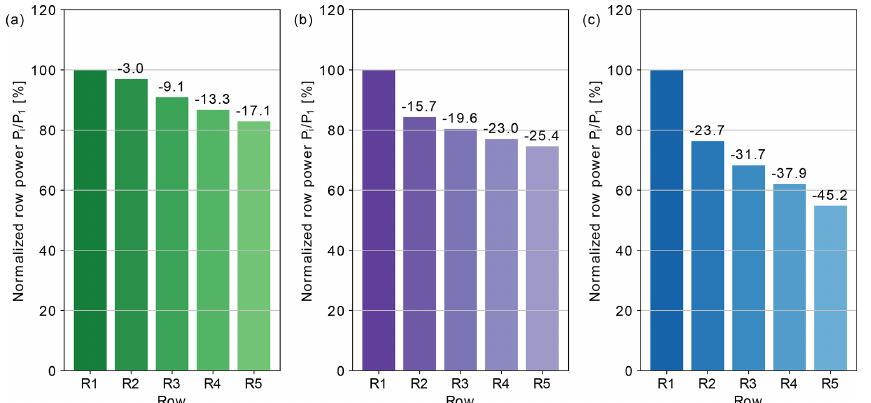
Figure 20. Mean row power averaged over 1h of park operation and normalised by tracked reference power P i /P